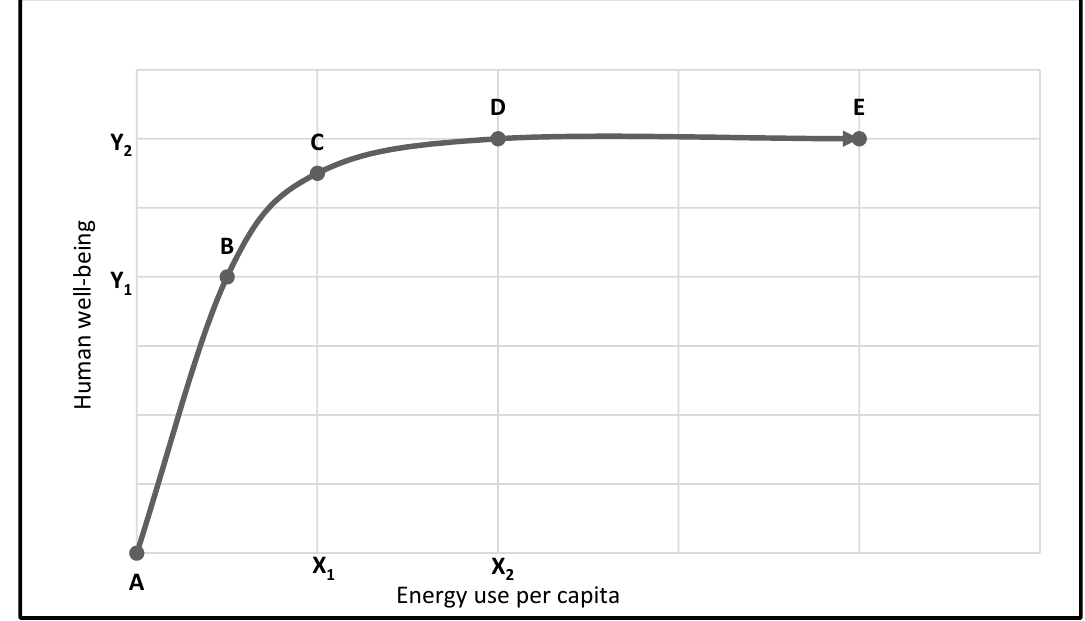
Figure 1. Energy su ffi ciency saturation curve. The value Y 1 represents the lowest acceptable level of human well-being while Y 2 represents the highest level of well-being attainable, as related to energy use. Line segments AB represent energy poverty, BD as energy su ffi ciency, and DE as energy excess. Energy su ffi ciency further includes a minimum range BC and a maximum range CD. This paper seeks to identify a range of values of energy use per capita X 1 to X 2 for the energy su ffi ciency maximum CD .